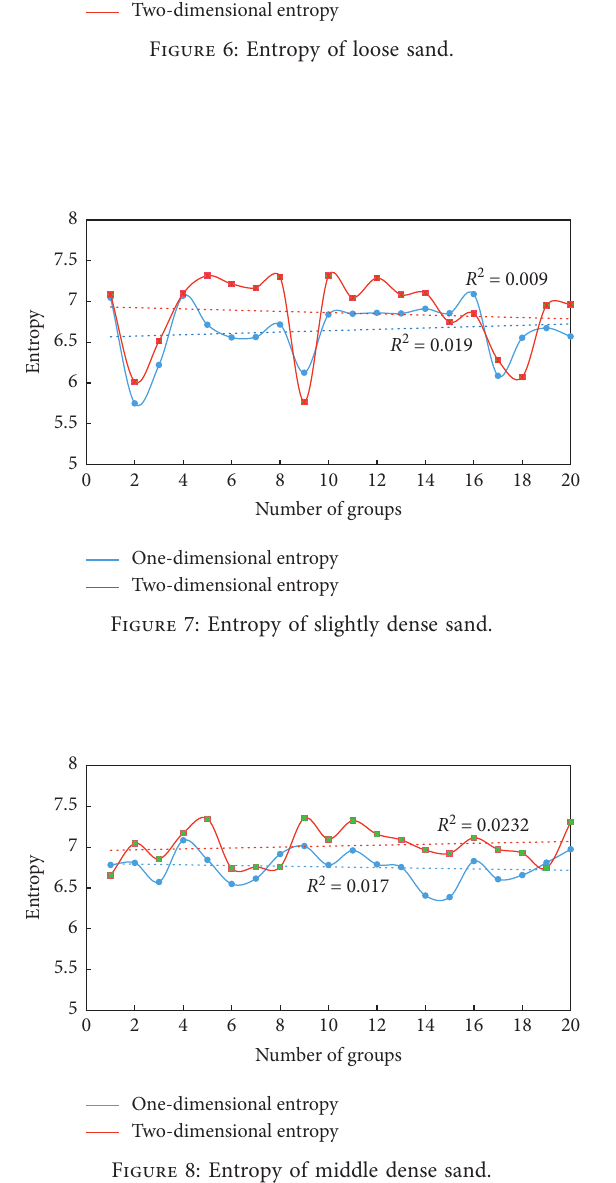
Figure 6: Entropy of loose sand.